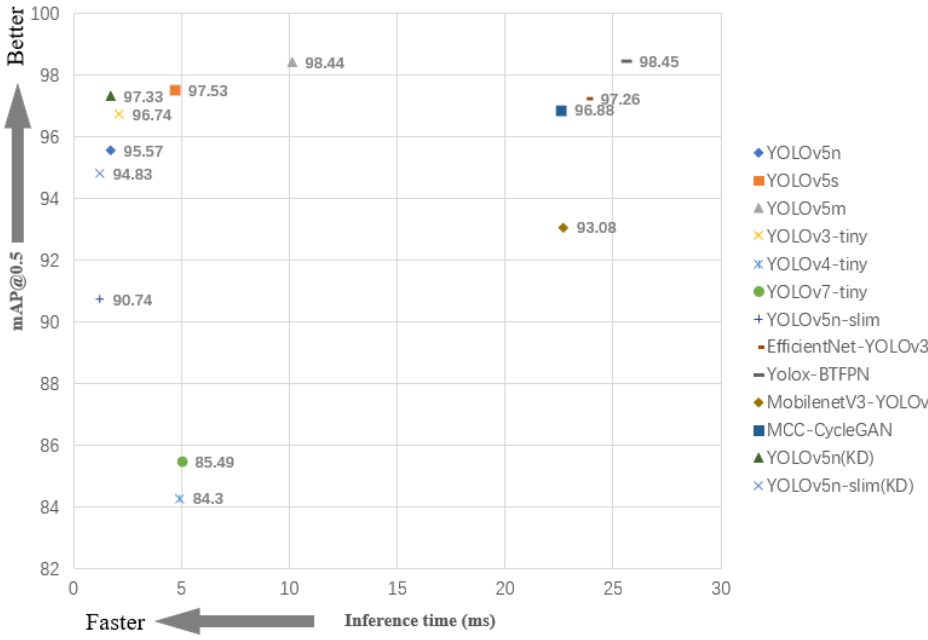
Figure 12. Performance comparison of the models.